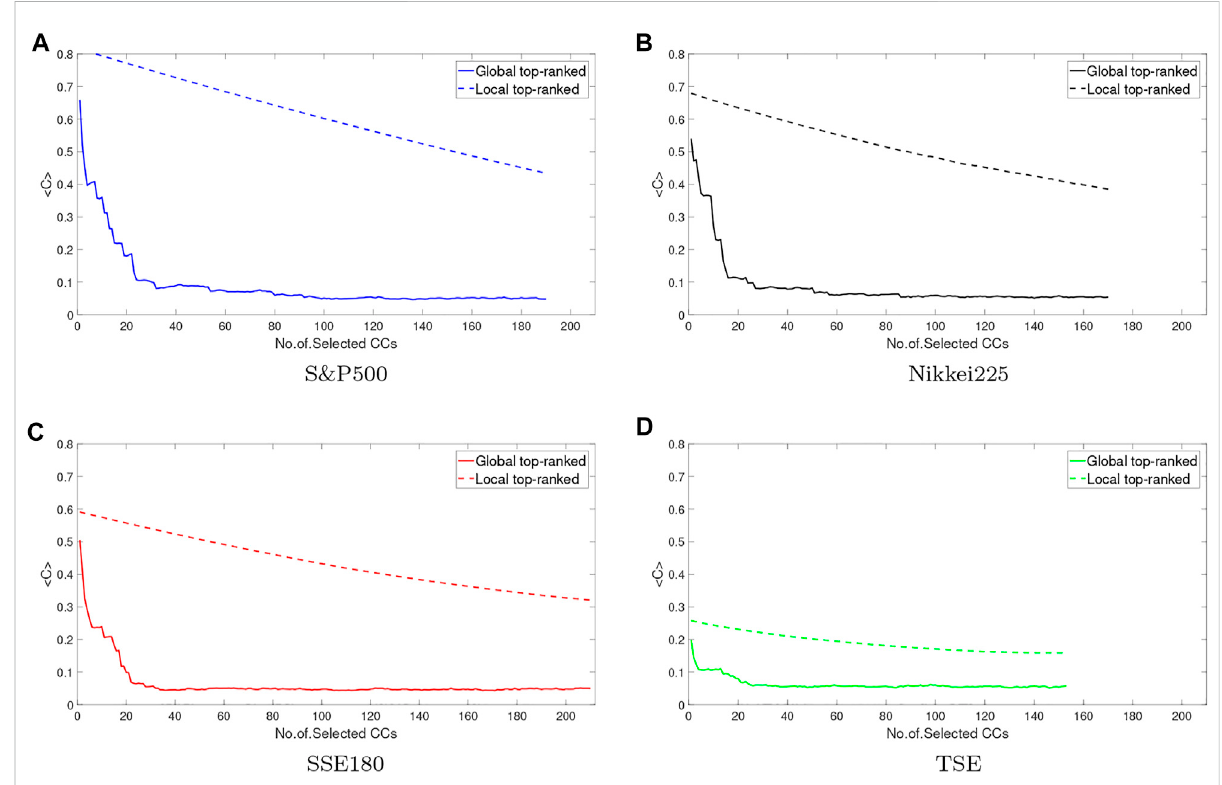
FIGURE 6 Comparisonofglobalperturbationandlocalperturbationforindices.Globalperturbationhasmoreeffectonindicesthanlocal.InTSEtheeffect of both types is weaker than another. Because this market is isolated from world markets. (A) S&P500, (B) Nikkei225, (C) SSE180, (D)